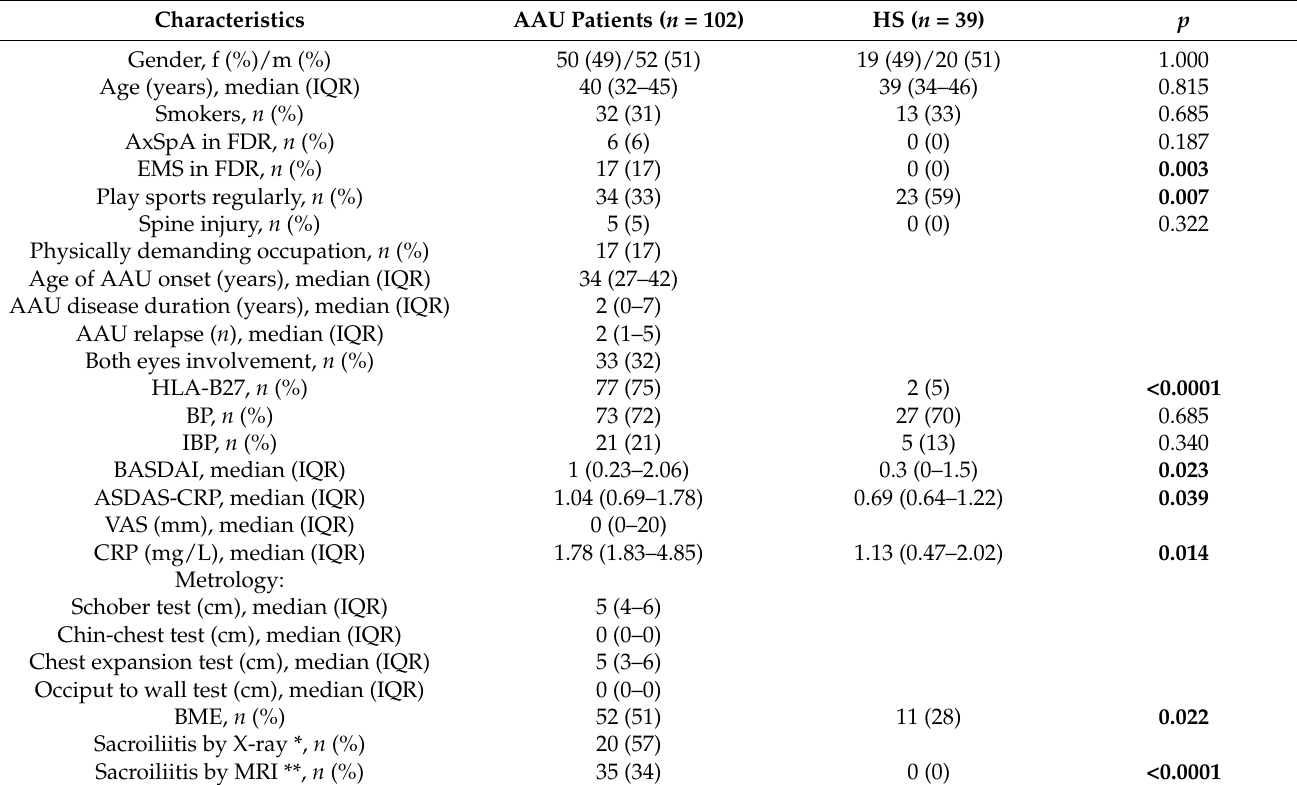
Table 1. Clinical characteristics of patients with anterior uveitis and healthy subjects (HS). Bold shows statistically significant